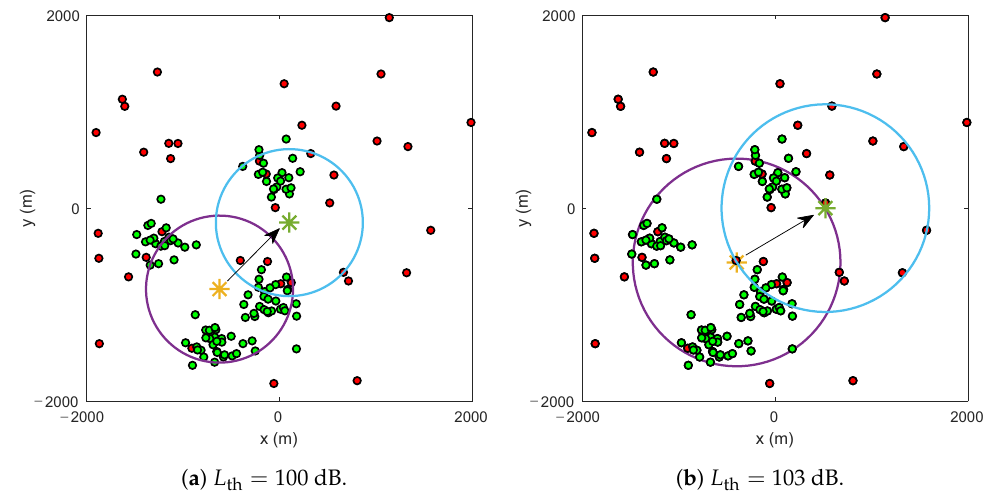
Figure 4. The optimal position of the UAV using the conventional and proposed algorithms in urban environment for different threshold path losses; a = 2000 m, M = 100, N = 50.